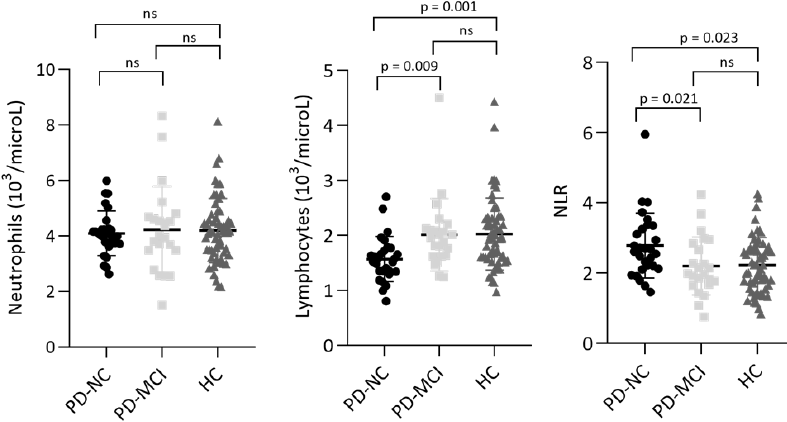
Figure 2. Kruskal–Wallis test with Bonferroni correction for levels of circulating neutrophils, lymphocytes, and NLR in PD and HC. Data are plotted as means and standard deviations.